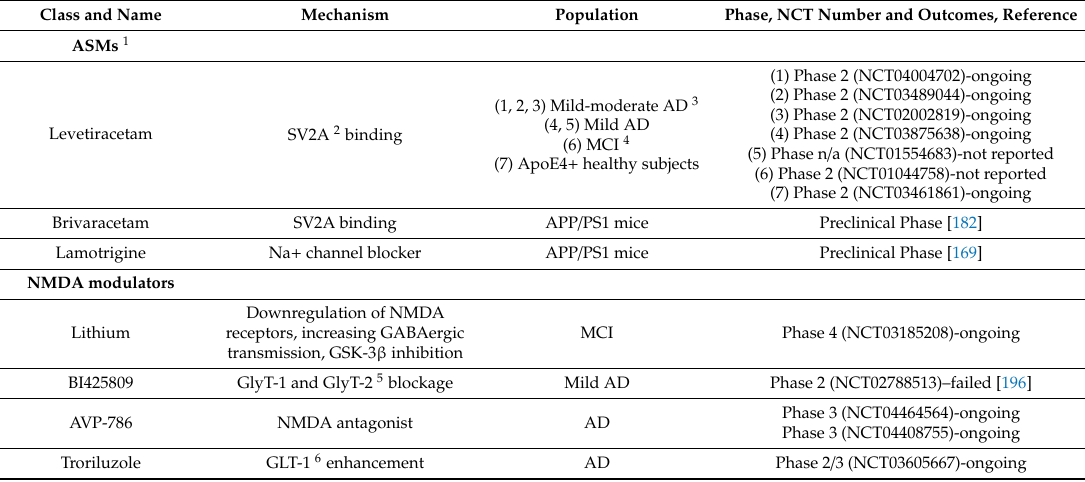
Table 2. ASM and pro-epileptogenic compounds counteracting